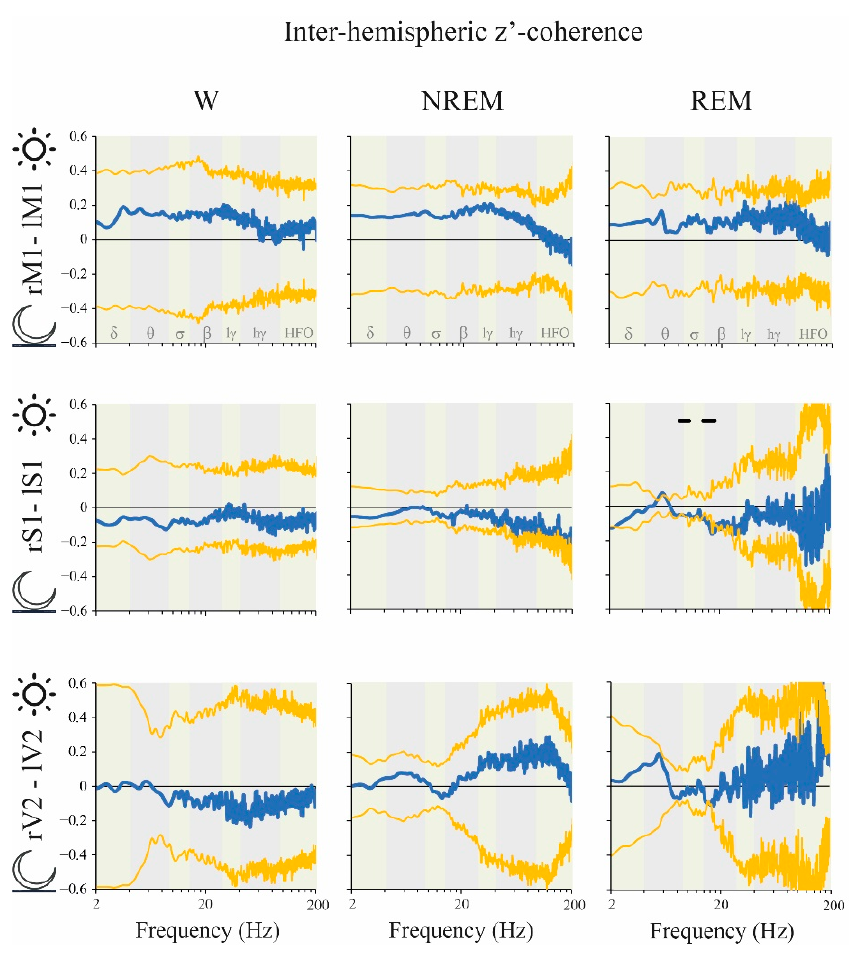
Figure 8. Inter-hemispheric z’-coherence: light vs. dark phases di ff erences. ( n = 11). The blue traces indicate the mean coherence di ff erence between light and dark phases. The yellow lines represent the standard deviation of the mean with respect to zero. The statistical evaluation was performed by the two-tailed paired t -test with Bonferroni correction for multiple comparisons; no significant di ff erences were observed. We also performed a data-driven approach comparing empirical clusters of frequencies; black lines represent statistical di ff erences in cluster of frequencies, p < 0.05. During REM sleep, inter-hemispheric S1 z’-coherence was higher during the dark phase for the clusters 8.5 to 10.5 Hz ( p = 0.008) and 14 to 18.5 Hz ( p = 0.005). M1, primary motor cortex; S1, primary somato-sensory cortex; V2, secondary visual cortex; r, right; l, left; l γ , low gamma or LG; h γ , high gamma or HG; HFO, high frequency oscillations.